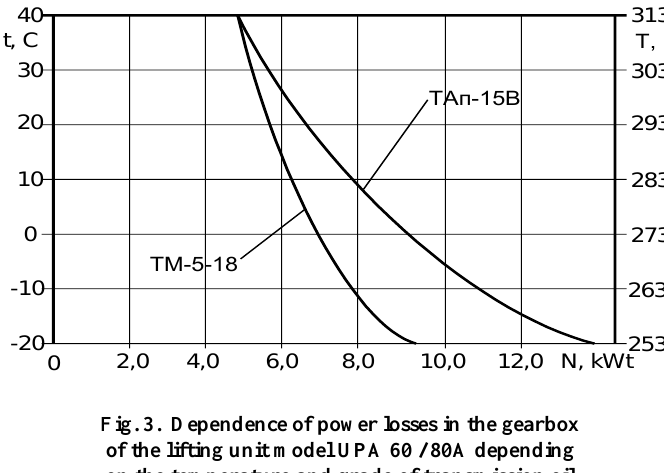
Fig. 3. Dependence of power losses in the gearbox of the lifting unit model UPA 60 / 80A depending on the temperature and grade of transmission oil